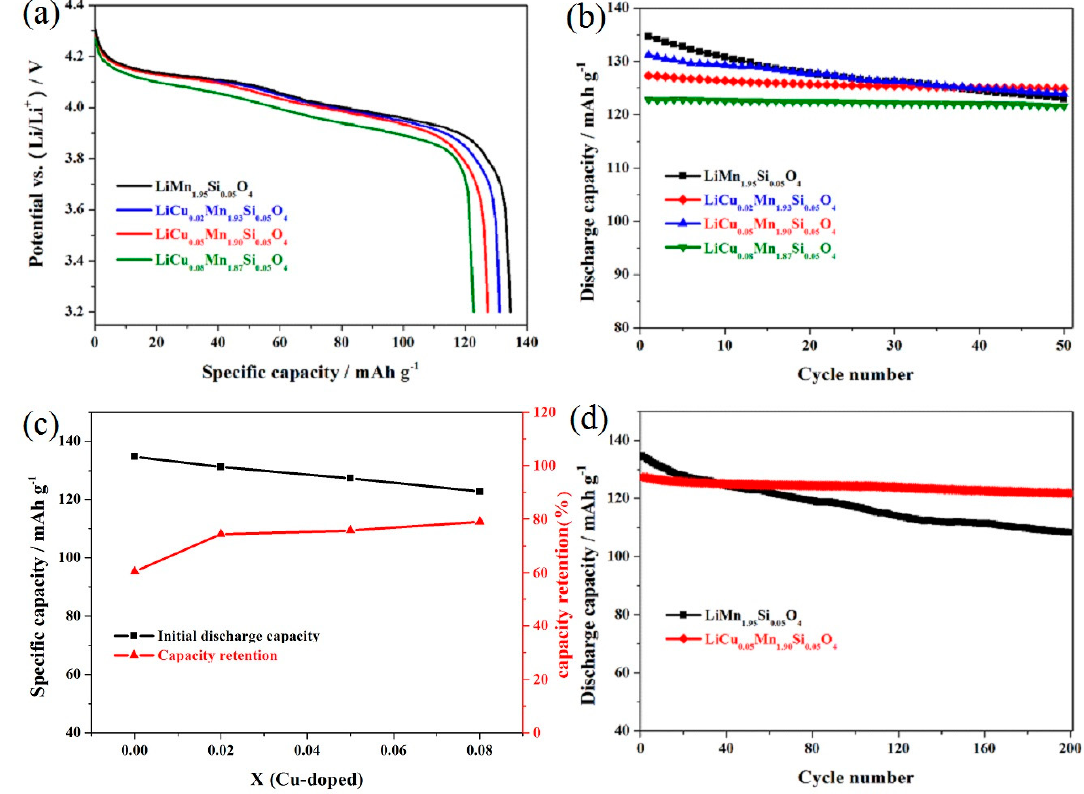
Figure 3. ( a ) Initial discharge curves and ( b ) Cycling performance of the LiCu x Mn 1.95 − x Si 0.05 O 4 (x = 0, 0.02, 0.05, 0.08) samples; ( c ) Comparison plots of the initial discharge capacities and capacity retentions; ( d ) Long Cycling performance of the LiCu x Mn 1.95 − x Si 0.05 O 4 (x = 0, 0.05) samples.